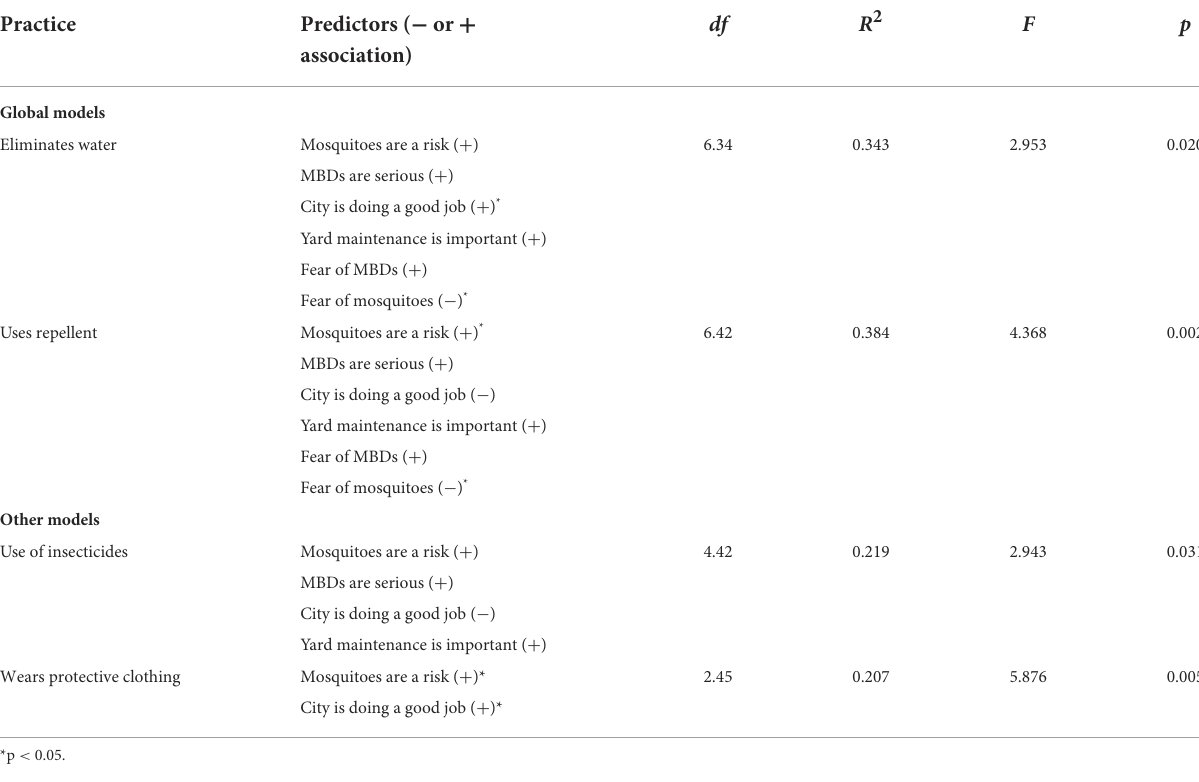
TABLE 7 Multiple regressions for attitudes predicting practices.